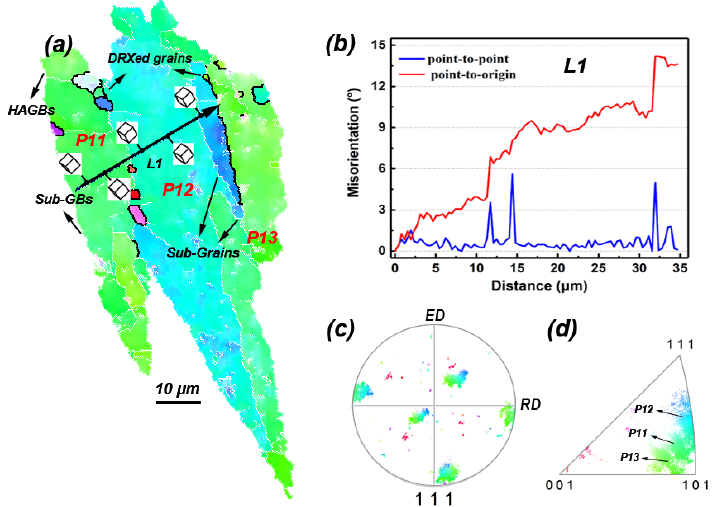
Figure 15. The DRX behavior of the deformed region (A1) selected in Figure 14a: ( a ) IPF coloring map, ( b ) line profile of MA along the line L1 in ( a ), and corresponding ( c ) (111) pole figure and ( d ) inverse pole figure.